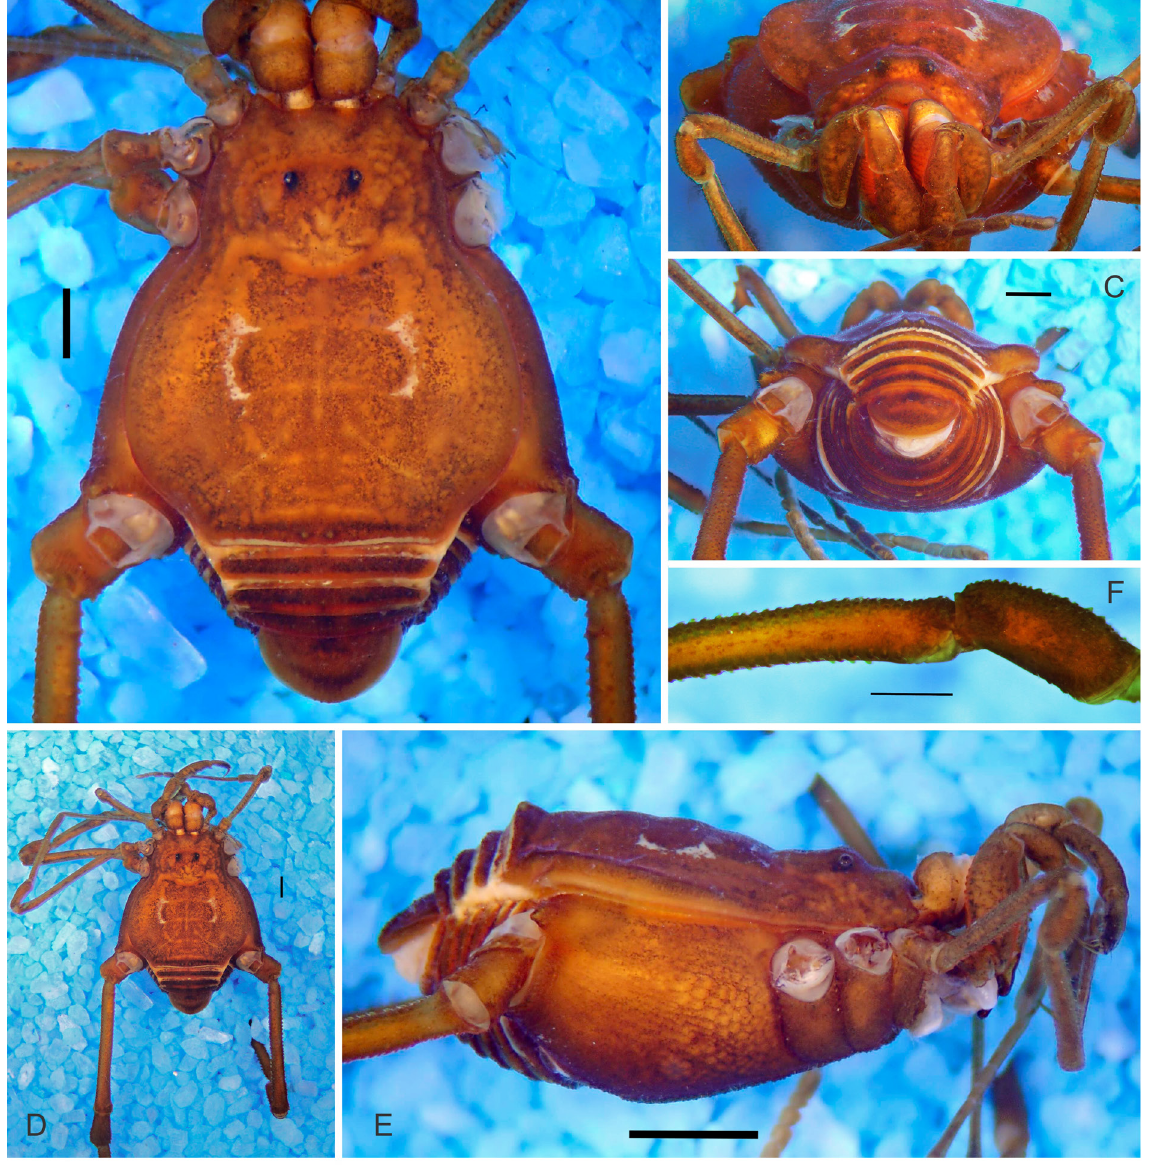
Fig. 8. Eulibitia clytemnestra sp. nov., ♂, holotype (ICN-AO 1148), habitus. A . Dorsal view. B . Frontal view. C . Posterior view. D . Panoramic, dorsal view. E . Lateral view. F . Detail of apical distal part of femur IV and trochanter. Scale bars: 1